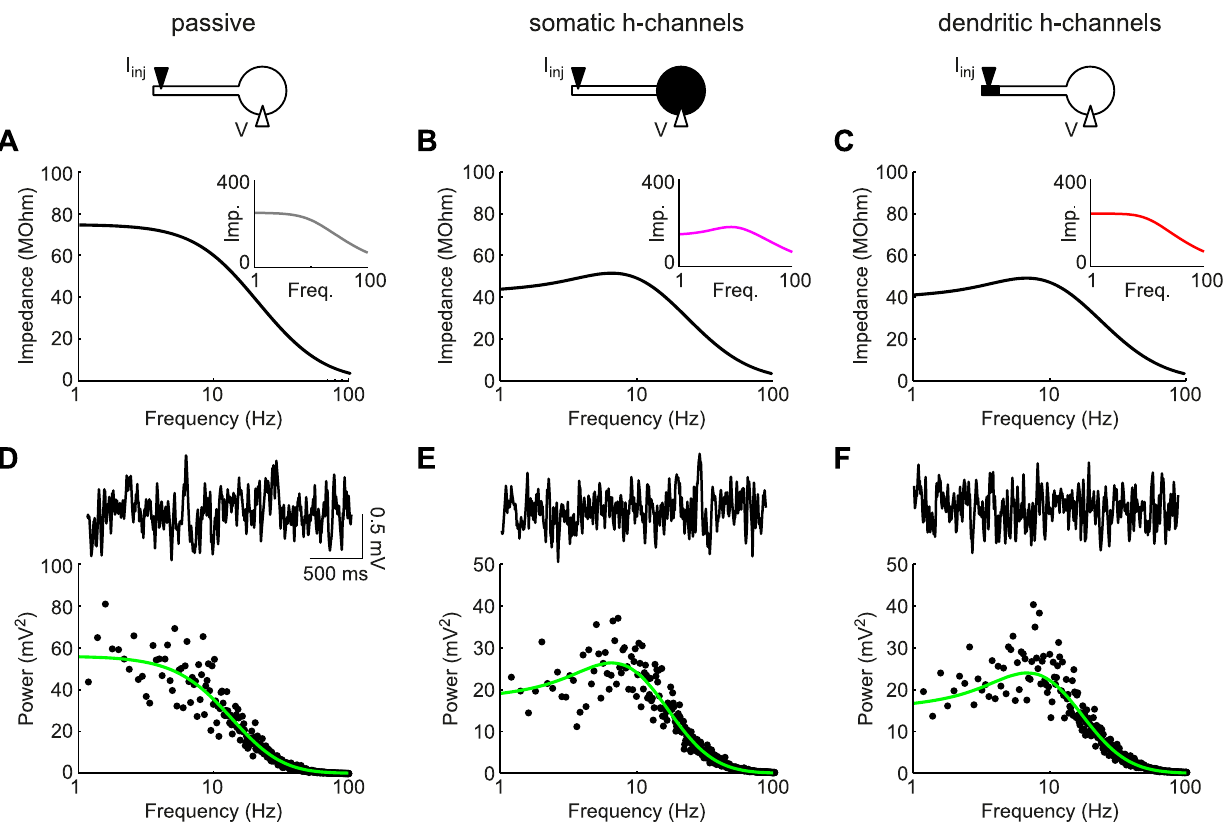
Figure 2. Signals of dendritic origin reflect dendritic resonance in the somatic compartment. (A–C): Dendro-somatic transfer impedances for an entirely passive neuron (A), a cell with h-channels localized in the soma (B), and a neuron with h-channels in the distal end of the dendrite (C). Insets show local somatic impedances from Figure 1. In contrast to the input impedances, transfer impedances showed a resonant peak, independent of whether h-channels were located somatically (B) or dendritically (C). (D–F): For all three models white noise current was injected at the distal dendritic end. Based on numerical simulations of the (in the two cases with h-conductances nonlinear) model equations, example voltage traces were obtained (solid black curves). Power spectra of responses (black dots) agreed with the squared dendro-somatic transfer impedances (green curves). Dendritic resonance-induced MPOs could be seen in somatic measurements despite the apparent absence of the resonance (F).